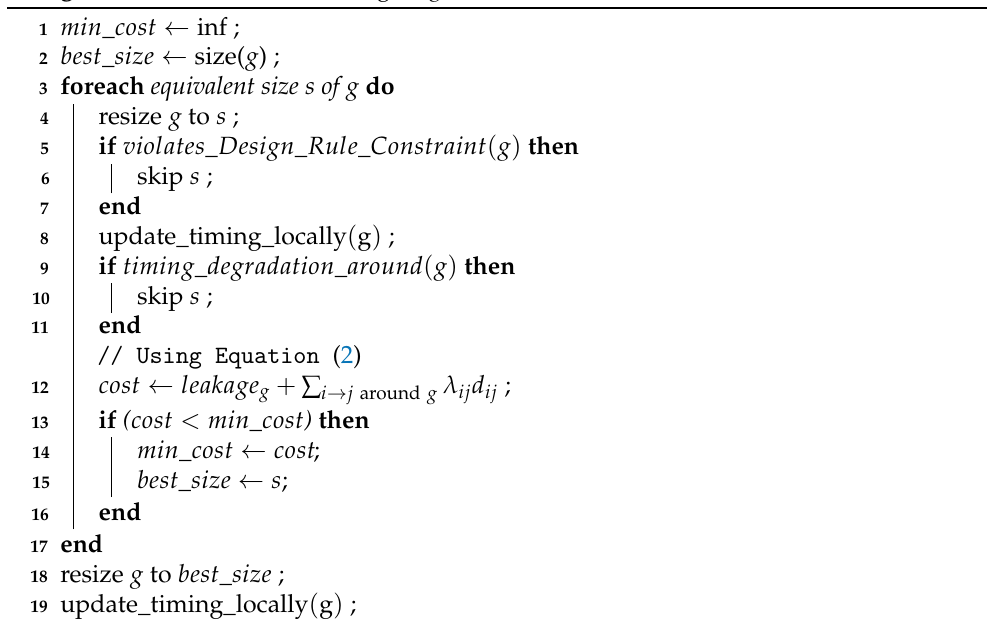
Algorithm 1: Find best size for gate g